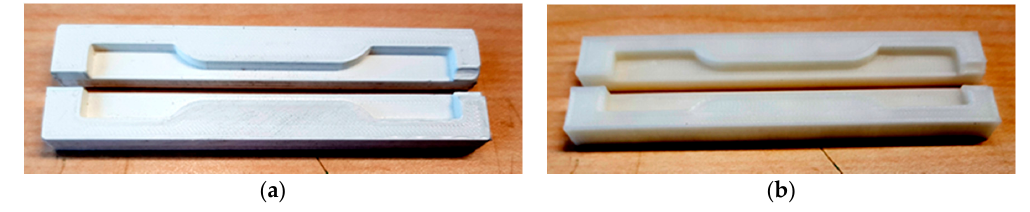
Figure 4. ( a ) ABS Split mold insert and ( b ) nylon split mold insert.